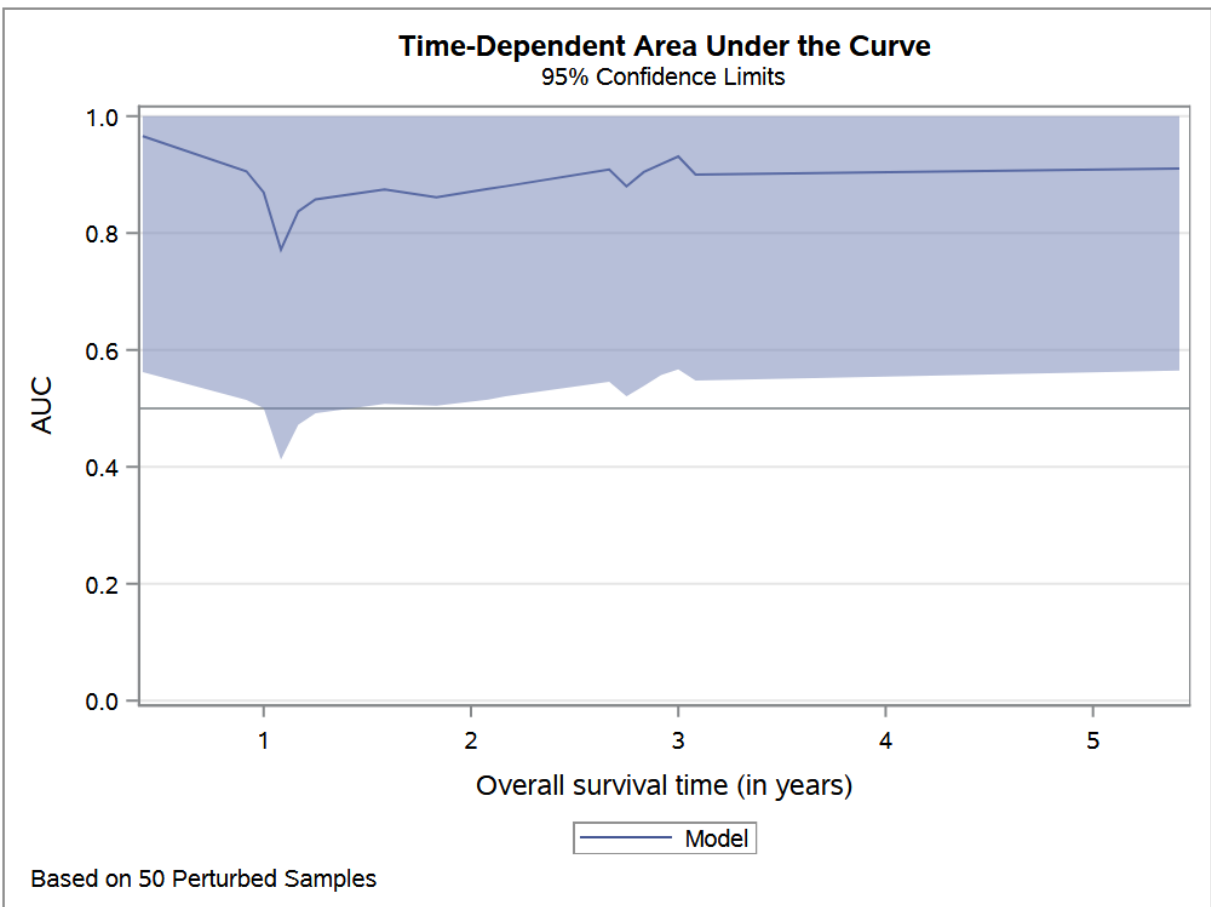
Figure 1. Time-dependent area under the ROC curve of overall survival multivariable model, including LDH.